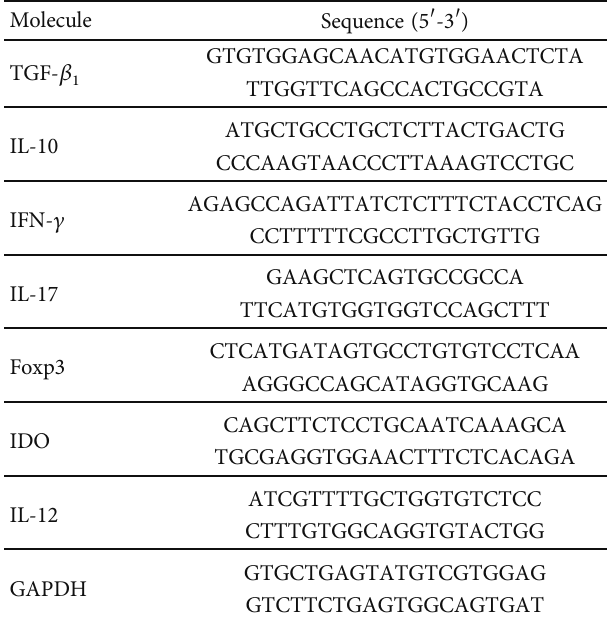
Molecule Sequence (5 ′ -3 ′